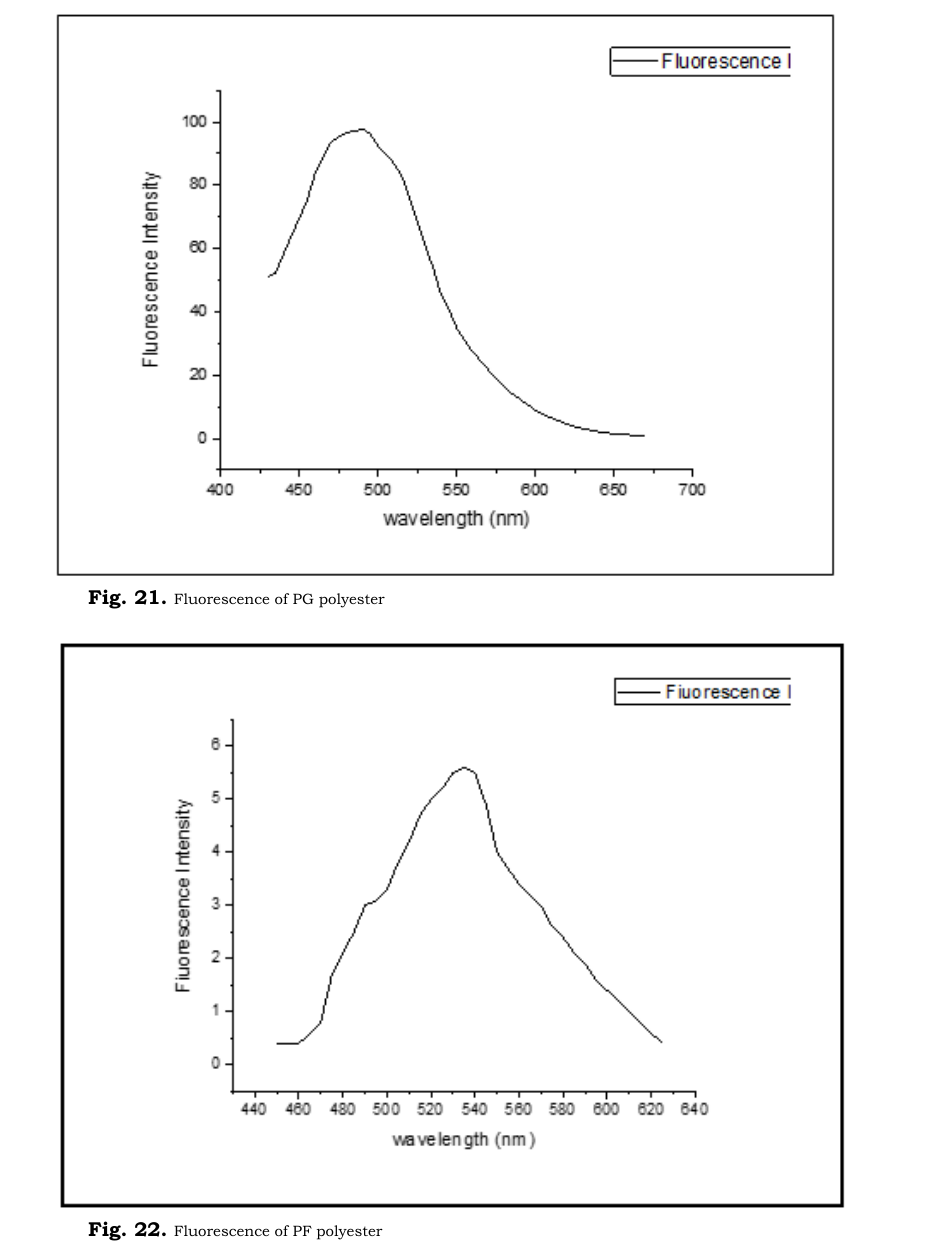
Fig. 22. Fluorescence of PF